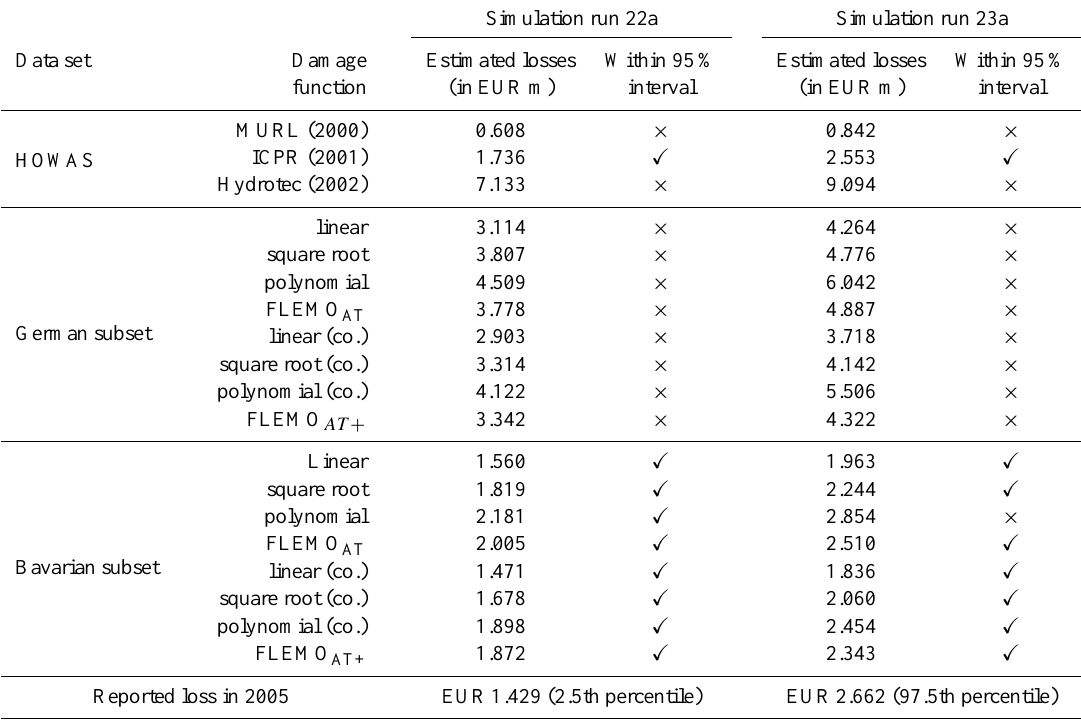
Table 4. Comparison of different loss estimates with the observed flood damage (95% confidence interval) on residential buildings for the flood event of August 2005 ( X and × means that estimate lies within or outside the confidence interval). Note: for all loss estimates only mean specific asset values are taken into account